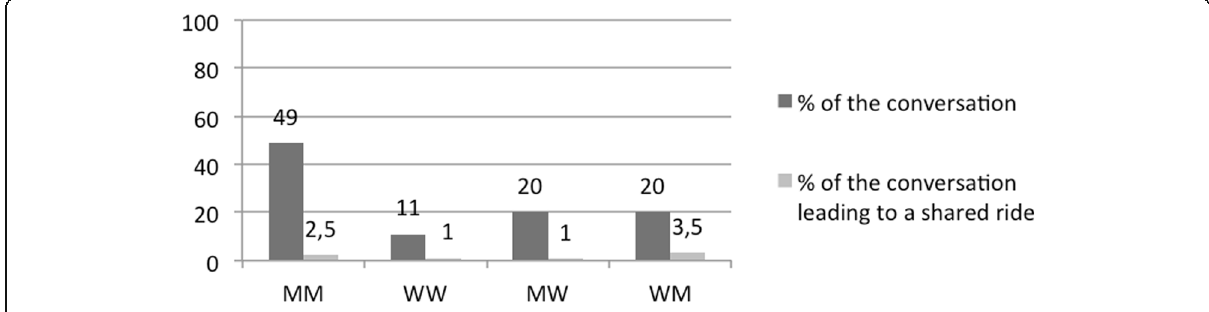
Fig. 4 Proportion of overall conversations ( n = 280) by gender and by outcome of the conversation (M = Man, W=Woman)